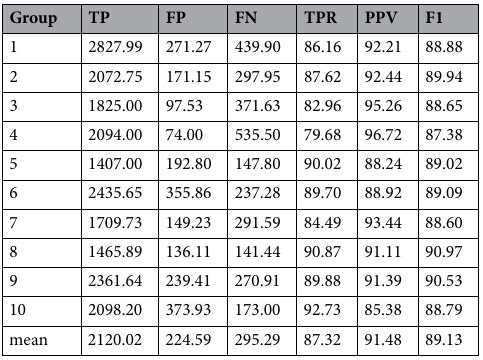
Table 2. Average values of TP , FP , FN , TPR , PPV and F 1 to assess the accuracy of kidney contour detection.